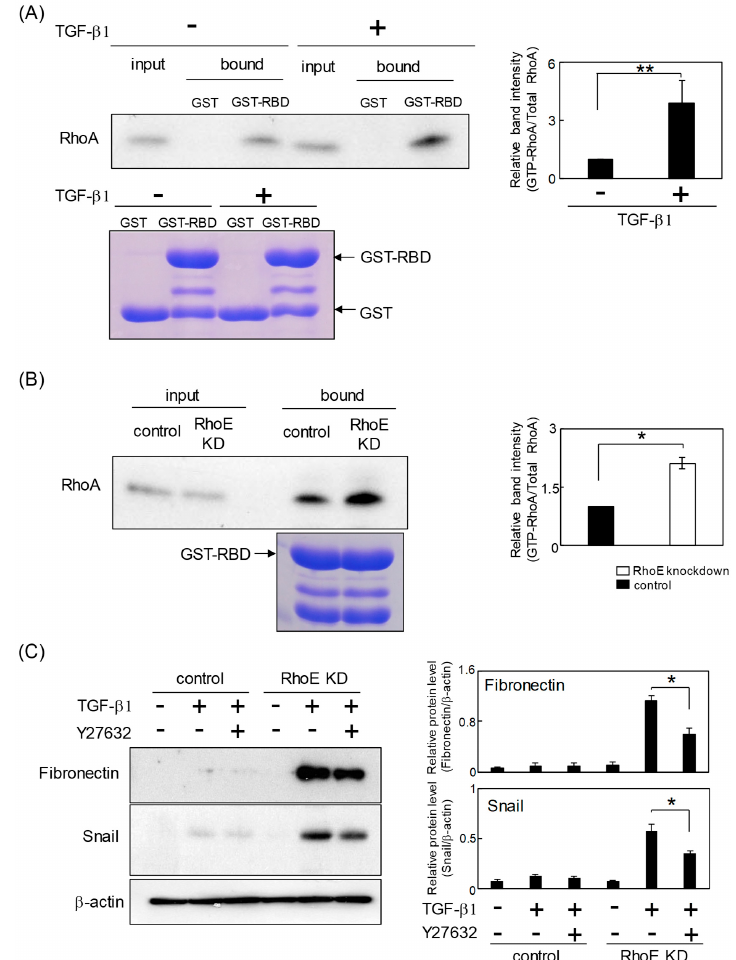
Figure 5. Reduction of RhoE upregulates RhoA activity during TGF- β -mediated EMT in HeLa cells. ( A ) Whole-cell lysates prepared from HeLa cells treated with TGF- β 1 or vehicle were used for the GST pull-down assay with GST or GST–rhotekin Rho binding domain (RBD). The lower panel indicates Coomassie blue staining of GST proteins. Bound protein samples were immunoblotted with